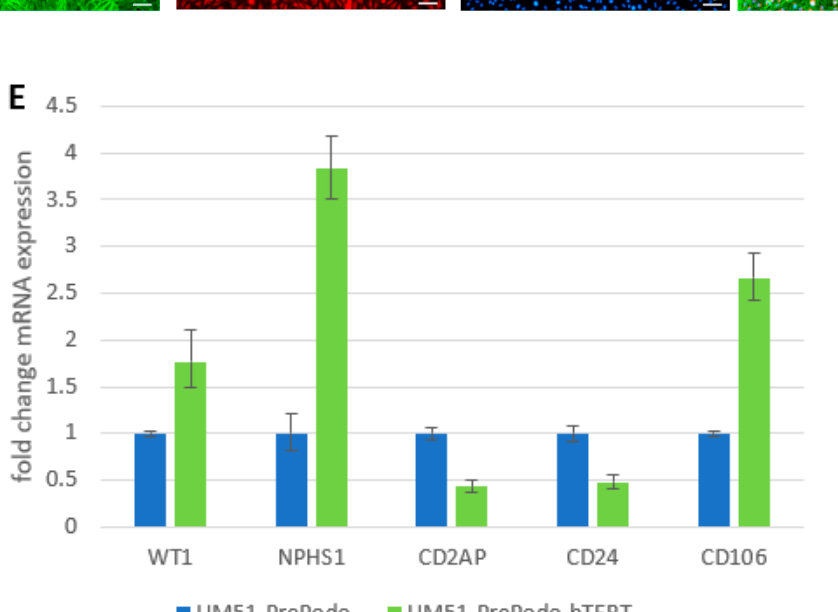
Figure 2. Characterization of immortalized UM51-PrePodo-hTERT. WT1 and NPHS1 expression in the parental UM51-PrePodo as well as the immortalized UM51-PrePodo-hTERT cells were evaluated by immunofluorescence-based detection ( A – D ) (scale bars: 100 µm). Immunofluorescence-based detection of the parental UM51-PrePodo is given in ( A , C ), while UM51-PrePodo-hTERT is given in ( B , D ). Cytoskeleton was stained with phalloidin. mRNA expression of WT1 , NPHS1 , CD2AP , CD24 and CD106 was determined by quantitative real-time PCR ( E